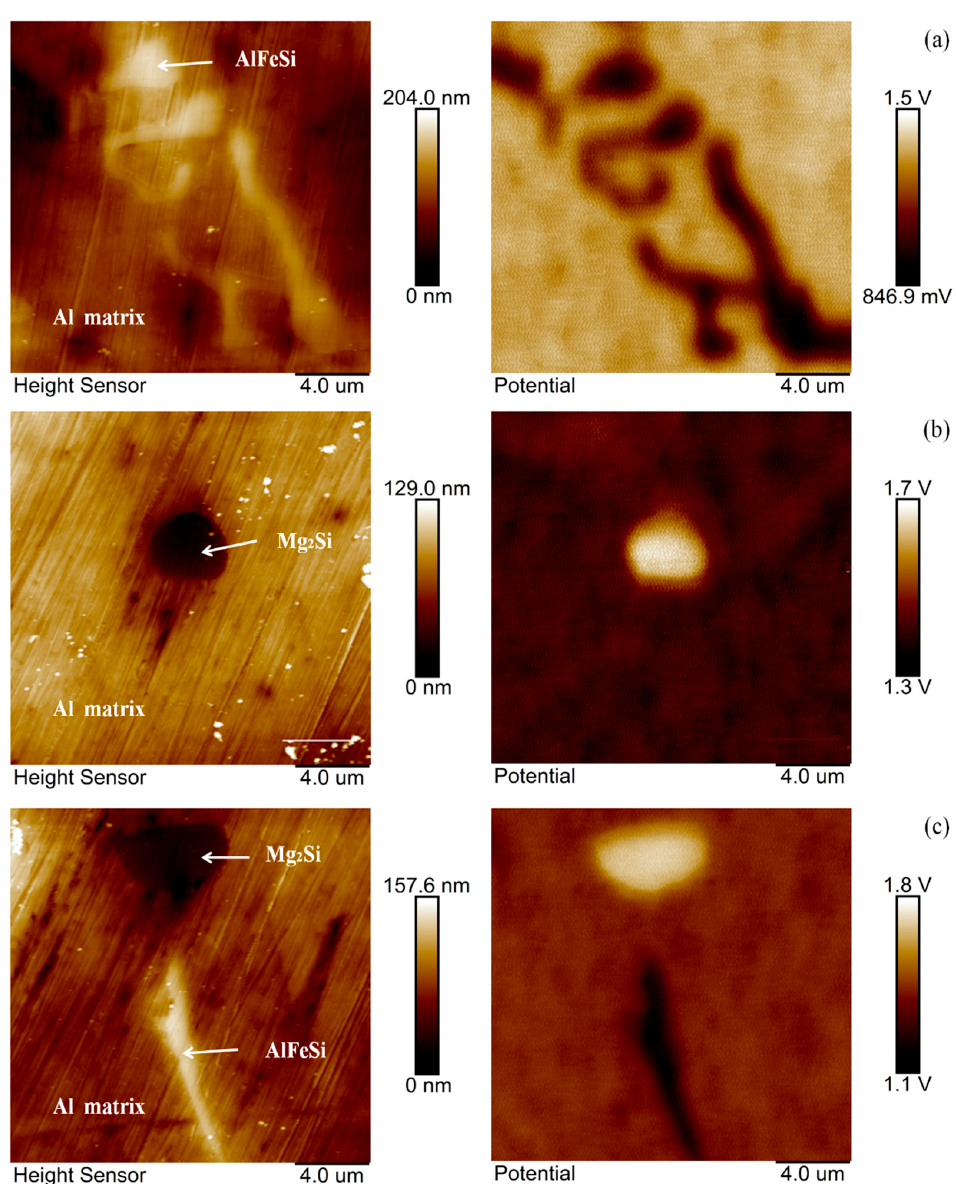
Figure 6. Topography and Volta potential maps of different second phases aged at 180 °C for 5 h: ( a ) AlFeSi phase and matrix, ( b ) Mg 2 Si phase and matrix, and ( c ) AlFeSi phase, Mg 2 Si phase and matrix.